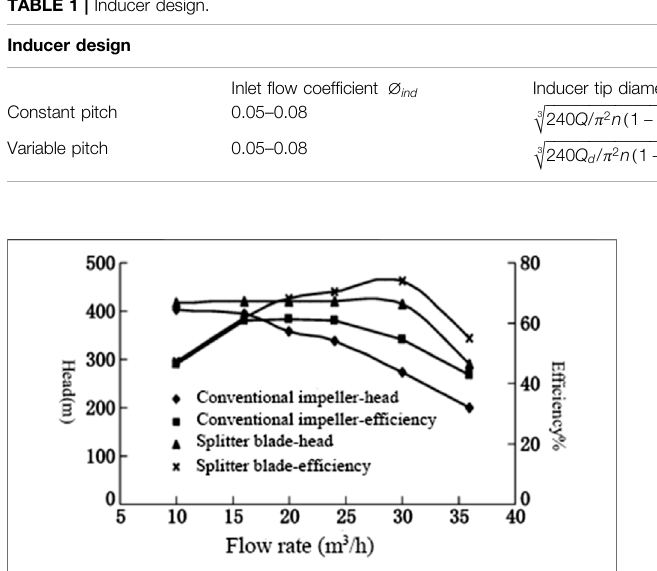
TABLE 1 | Inducer design.